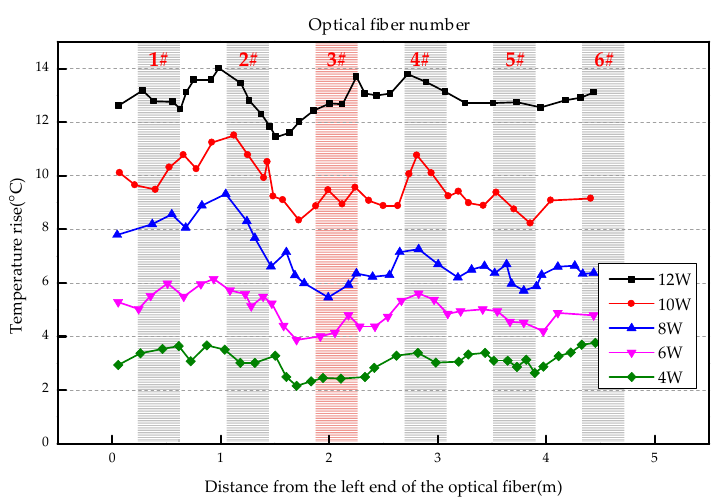
Figure 9. Temperature increase curve of seepage flow velocity at 100 mm/h.